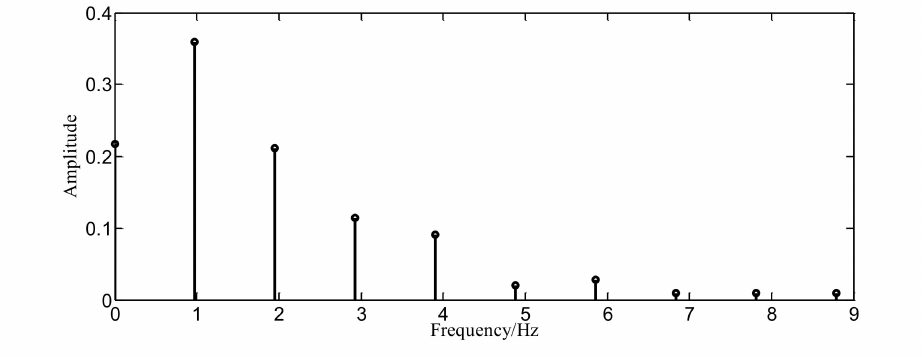
Figure 14. Amplitude spectrum for the weak magnetic signals of the steel cord conveyor belt